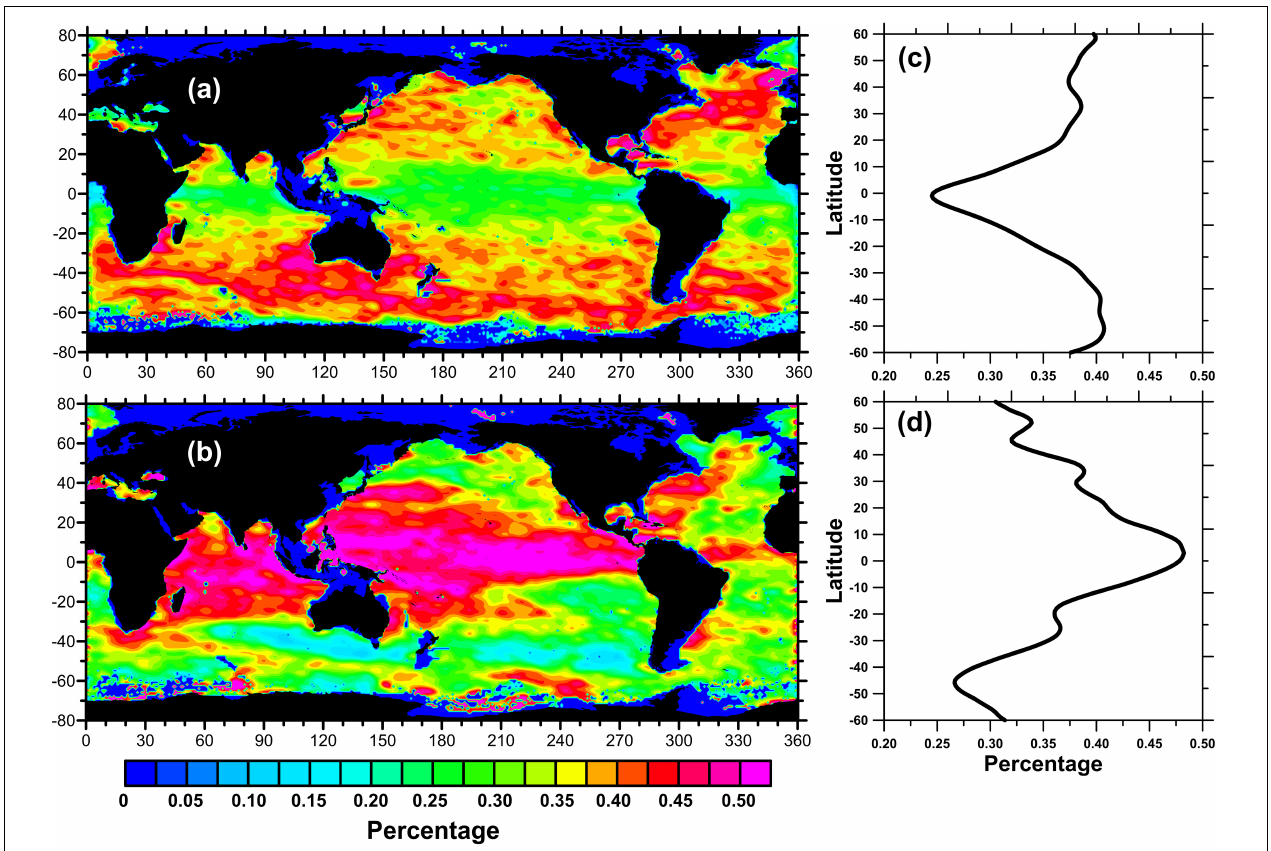
FIGURE 7 | Global geographic distribution of profiles inside Alt eddy and convolutional neural network with extreme gradient boosting (CNN-XGBoost) eddy during 2002 to 2019 under a 1 ◦ grid. (a,b) The frequencies of Argo profiles in Alt eddy and CNN-XGBoost eddy occurrence with respect to all Argo profiles within the same grid, respectively. (c,d) Corresponding zonal distributions of Panels (a,b)